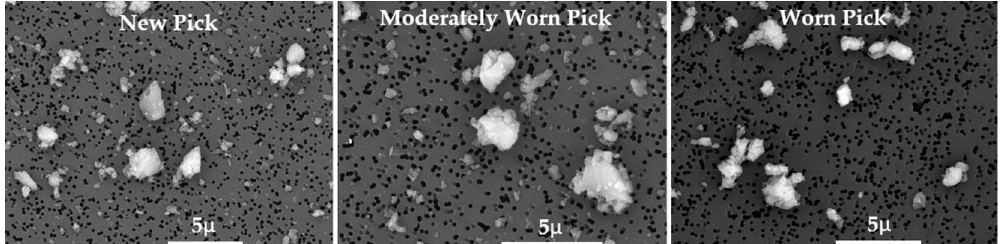
Figure 12. Raw FE-SEM example images of the particles generated from the new, moderately worn, and fully worn pick that shows the particles being similar shapes and sizes.